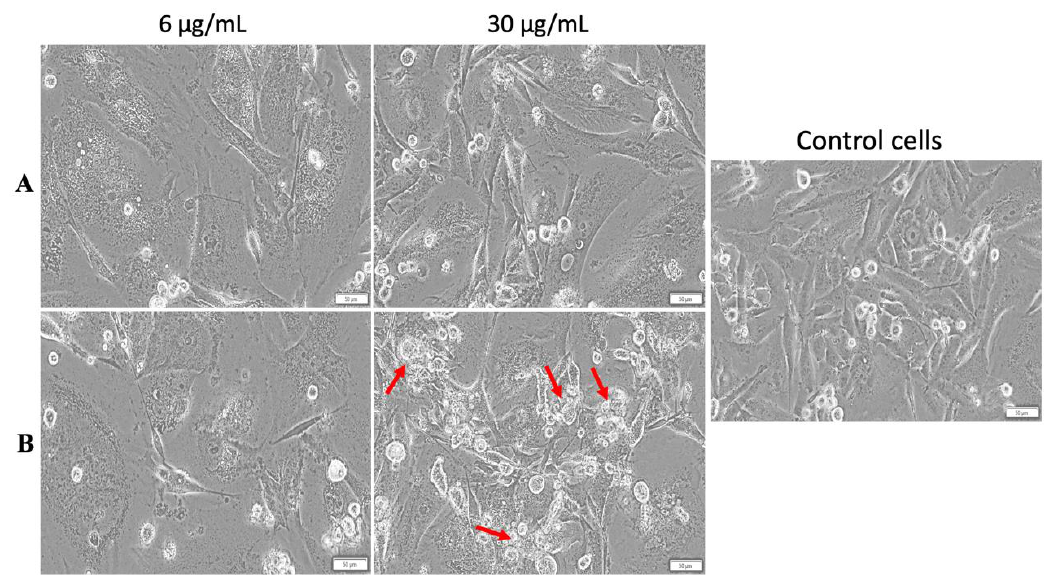
Figure 11. Morphology of MDA-MB-231 cells after treatment with MCS under standard ( A ) and hyperthermic conditions ( B ). Phase contrast pictures were taken 24 h postincubation at a magnification of 20×. Scale bars represent 50 µm. Cells undergoing morphological changes are marked with red arrows.